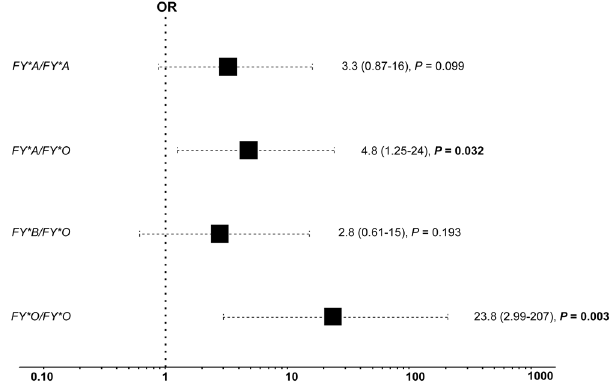
Figure 5. Association between the DARC genotype and antibody levels against PvMSP1 19 during the 12- month follow-up study in the Rio Pardo Settlement. The logistic regression model was adjusted for the time of residence in the endemic area and recent P. vivax infection. Only variables associated with anti-PvMSP1 19 antibody levels at a significance level of 0.05 ( P < 0.05) were maintained in the final model. The odds ratio (OR, 95% CI) was adjusted using FY * A/FY * B as the reference group. The text in bold indicates that the OR is statistically